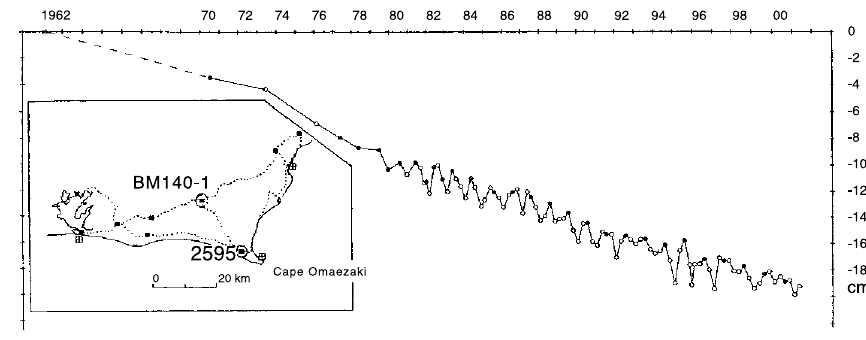
Fig. 12. Secular deformation of Cape Omaezaki since 1962 (after Geographical Survey Institute,